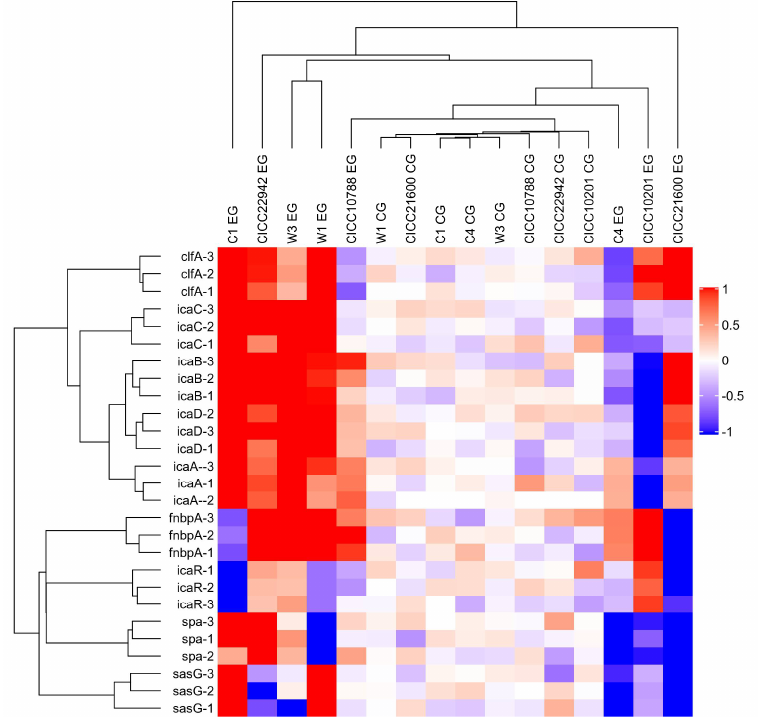
Figure 4. Heat map of the transcription levels of genes in the S. aureus biofilm cells under cold stress. Note: S. aureus without cold stress was used as the control group. The gene transcription levels in biofilm cells of S. aureus after cold stress for 20 weeks at −20 °C were tested. Meanwhile, EG indicated the experimental group, and CE was the control group. The red square indicated that the transcription levels of genes were obviously increased. The blue square indicated significantly decreased gene transcription.